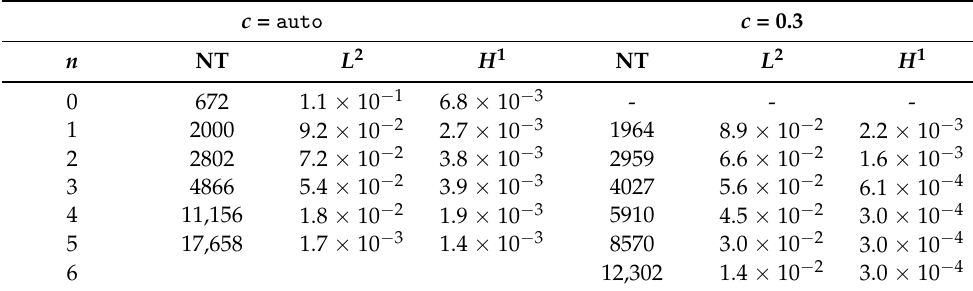
Figure 17. Results for example 3 with η N . ( Left ) The resulting adapted mesh. ( Right ) The resulting adapted mesh with the isolines projection of the computed solution. Table 9. Error in L 2 norm and H 1 seminorm for example 3 obtained with η N error